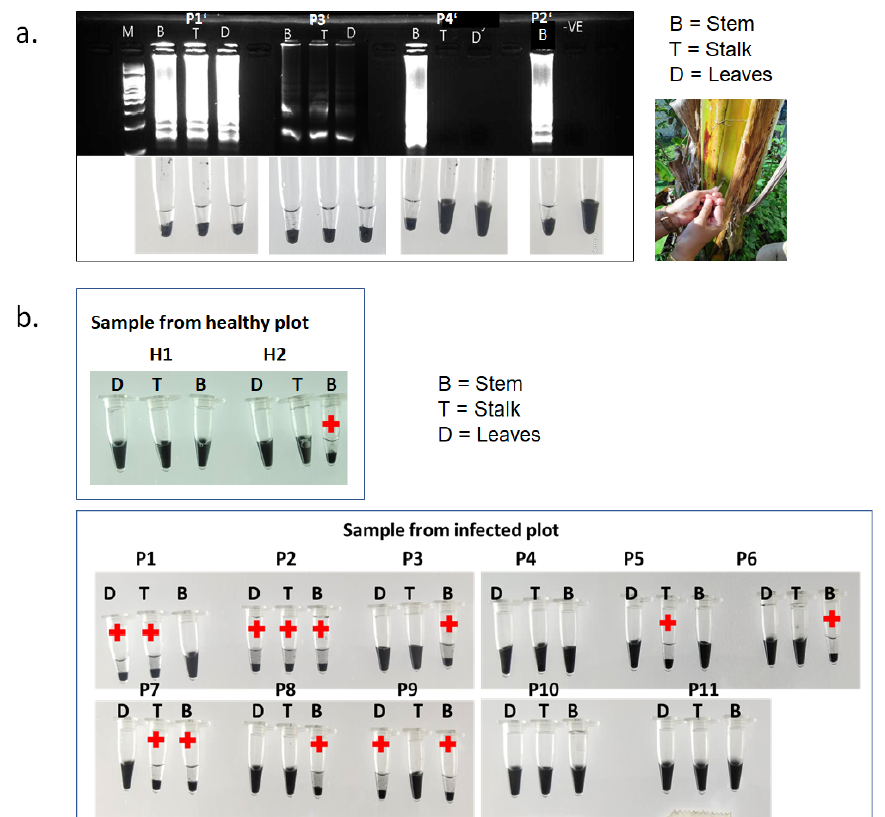
Figure 6. Assessment of the developed LAMP and carbon flocculation assays at two BDB hotspots: ( a ) MARDI headquarters; and ( b ) Taman Pertanian Universiti. ( + ) represents BDB detected in the sample. Each figure represents at least 3 experimental replicates.